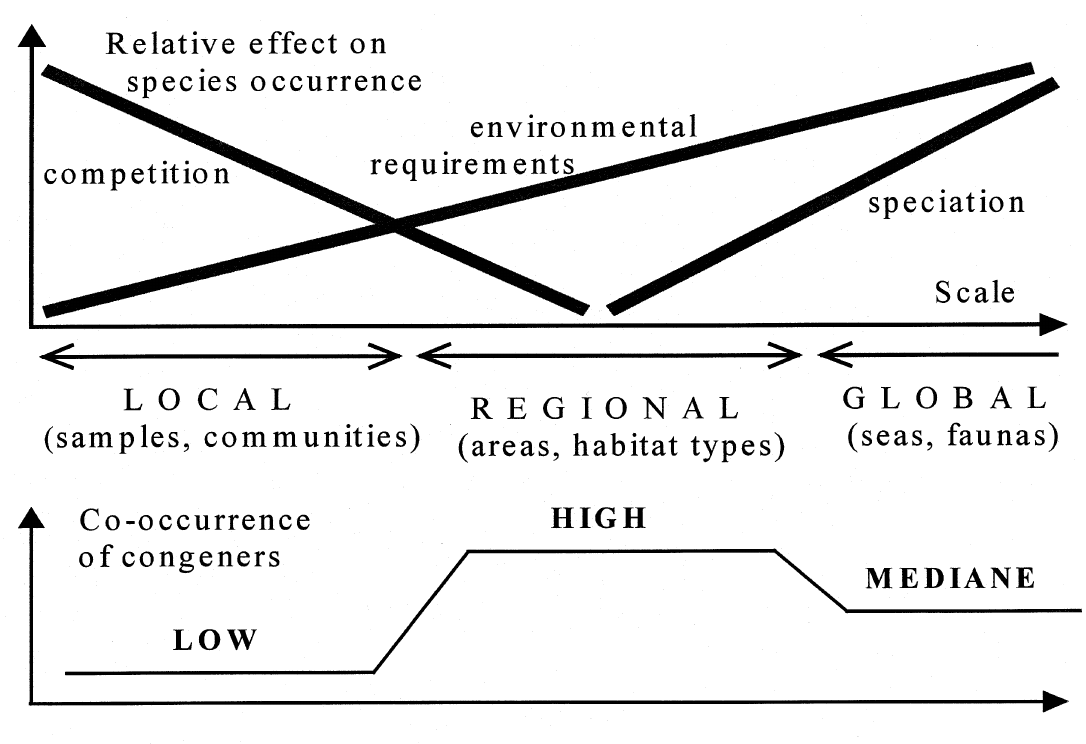
Fig. 6. Comparative role of ecological factors influencing species occurrence at different spatial scale (schematically, changed from Azovsky